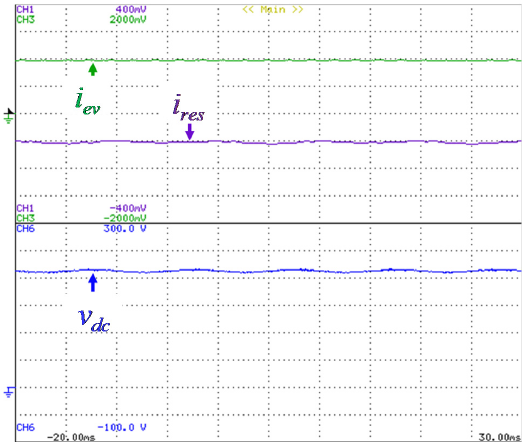
Figure 25. Experimental results during the MF-EVCS operation in R2G mode combined with G2V mode: Current in the EV battery ( i ev : 2 A/div); Current in the RES interface ( i res : 1 A/div); Dc-link voltage ( v dc : 50 V/div).